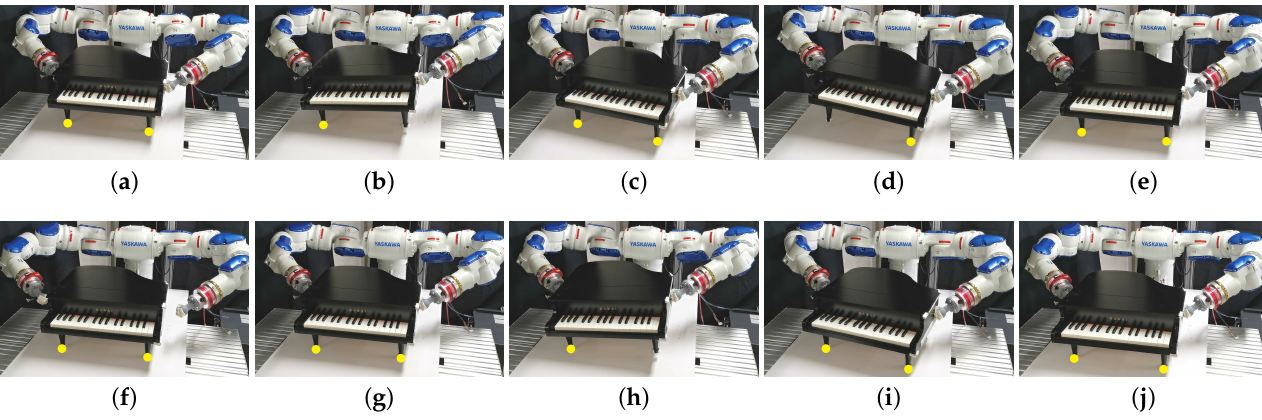
Figure 16. Experiment 1: The robot manipulates the object by pivoting in ( a – d ) and regrasping the object in ( e – g ). In ( e ), without regrasping, the robot cannot further move the object forward because the robot arms are close to the kinematic limit. However, after regrasping, the robot can move the object forward for two pivoting steps, see ( h – j ). The yellow dots indicate the object vertices that contact the